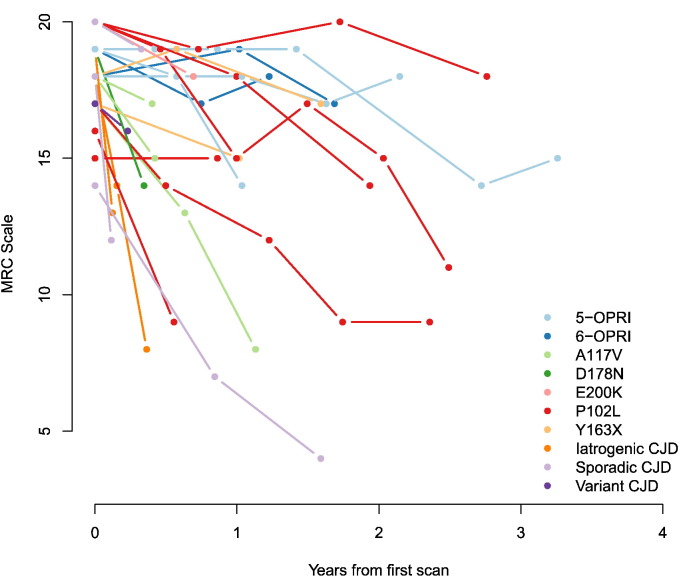
MRC Scale change over time for each of the 24 patients. Different etiologies and genetic mutations are shown in different colours.